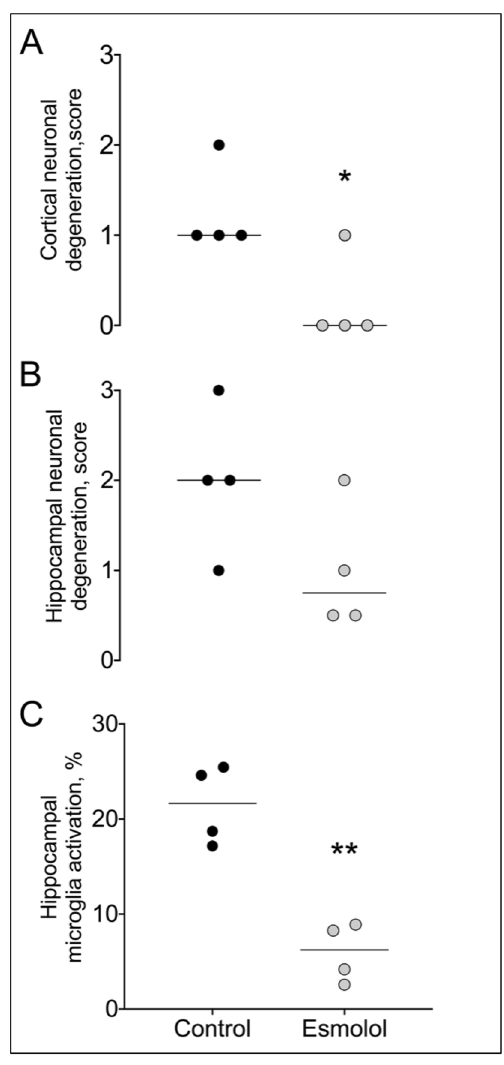
Figure 3. Brain histopathology. ( A ) Cortical and ( B ) Hippocampal neuronal degeneration/necrosis. ( C ) Microglia activation in the hippocampus. ** p < 0.001 vs.